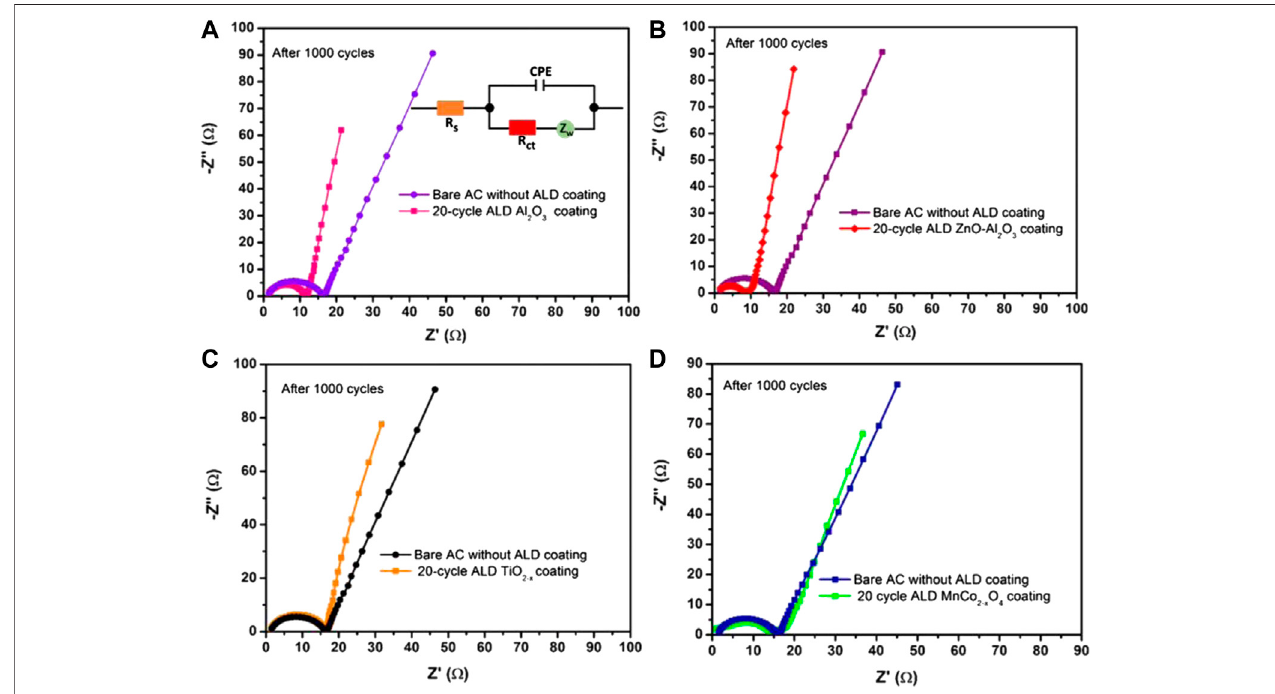
FIGURE 7 | Impedance behavior of AC-based cells with various coating materials after cycling tests. (A) Al 2 O 3 coating; (B) ZnO-Al 2 O 3 mixed coating; (C) TiO 2 − x coating; (D) MnCo 2 − x O 4 coating. The inset of (A) is the equivalent circuit model used to analyze impedance data of Nyquist plot.